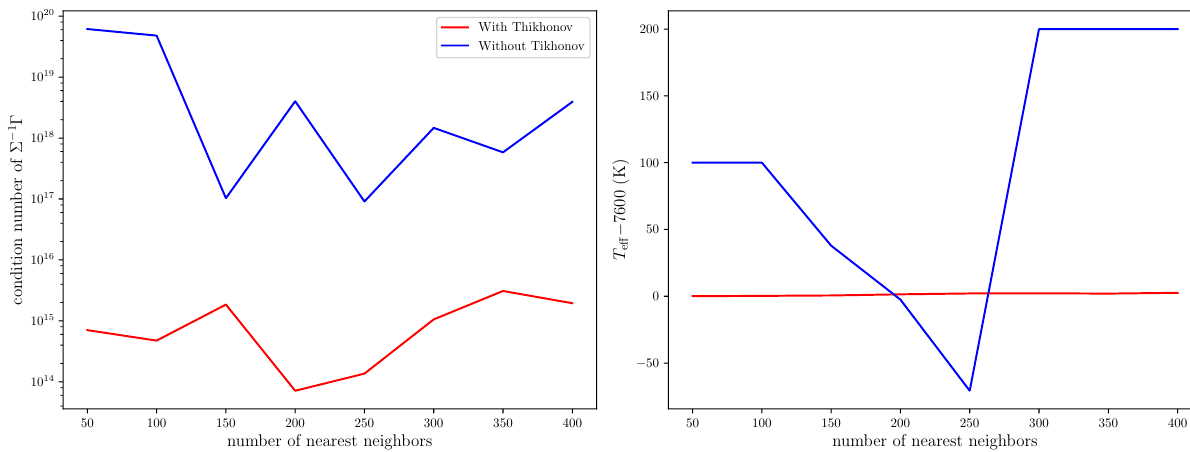
Figure 2. Left: variation of the condition number as a function of the number of nearest neighbor using the optimum reduced LDB with and without the Tikhonov regularization. Right: the inverted T eff as a function of the number of nearest neighbor with and without Tikhonov regularization. The inversion is done for a noise added synthetic spectrum with T eff =7600 K, log g =2.50 dex, [ M / H ]=0 dex, v sin i =197 kms −1 and S/N= 196. For clarity we display on the value of T eff -7600 K.